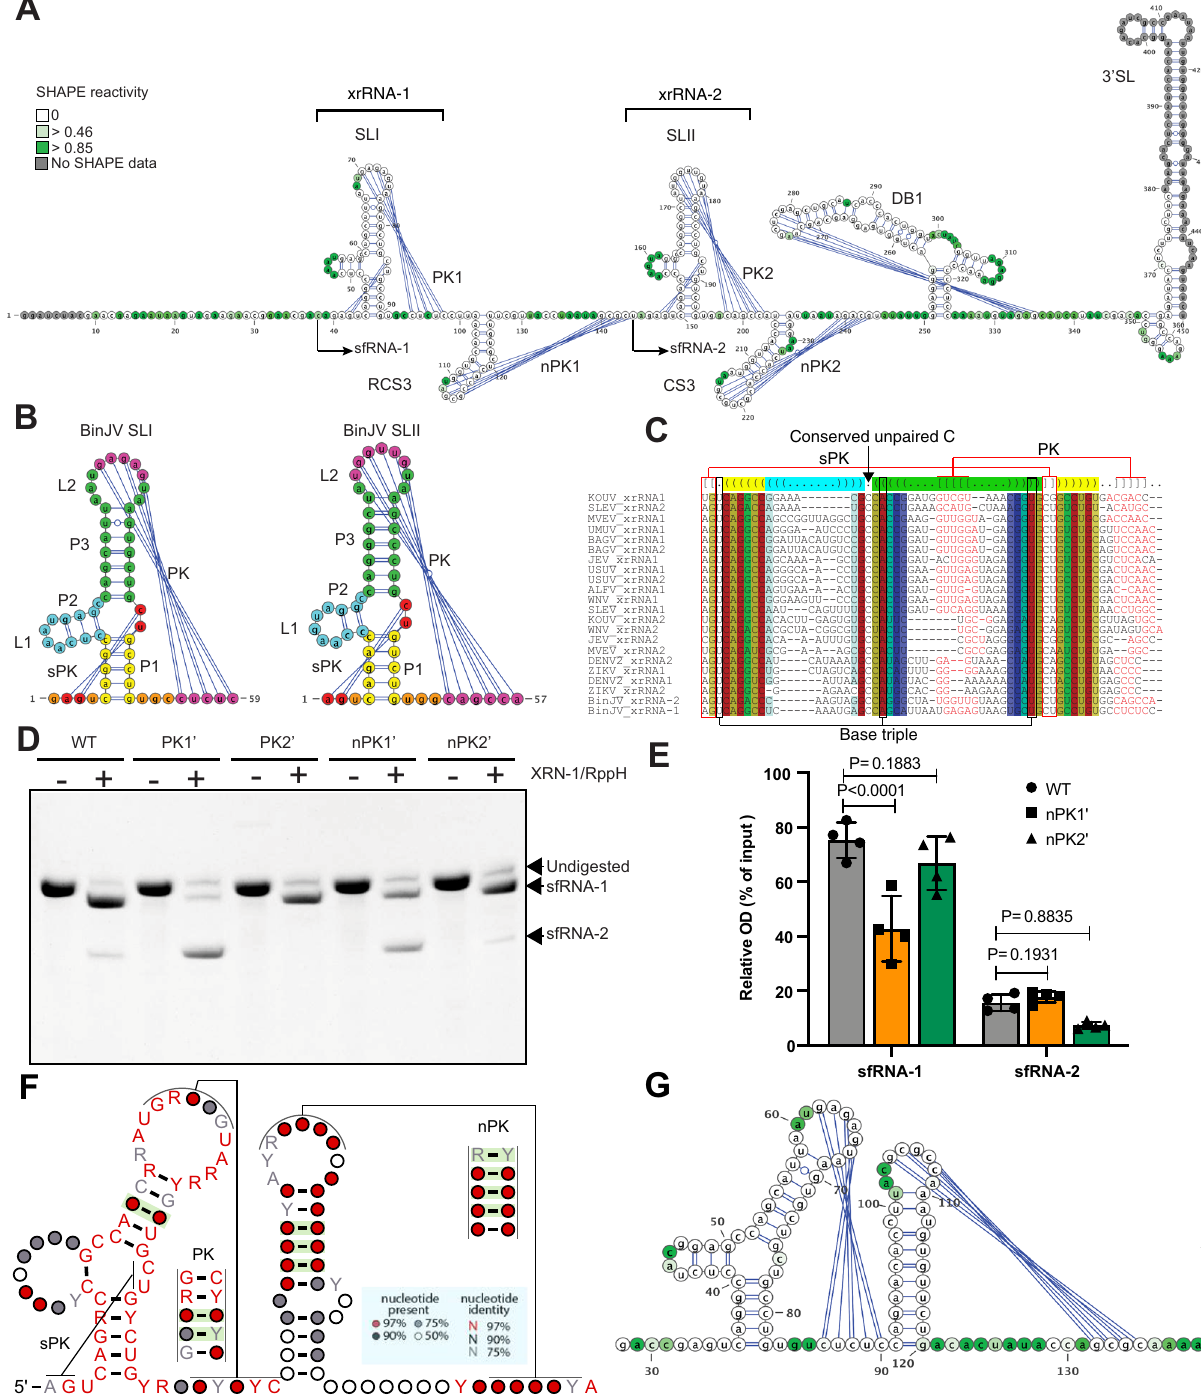
Fig. 2 dISFs contain novel SL-PK elements in addition to canonical class 1a xrRNAs. A Secondary structure of BinJV 3 ’ UTR generated by SHAPE. SL – stem- loop, DB – dumbbell, RCS3 – reverse conserved sequence 3, CS3 – conserved sequence 3, PK – pseudoknot. B Secondary structures of BinJV stem-loops. C Structure-based sequence alignment between BinJV and MBF xrRNAs. D XRN1 resistance assay with WT and mutated BinJV 3 ’ UTRs. Mutations PK1 ’ (GAGAG->CUCUC), PK2 ’ (UGGUUG->ACCAAC), nPK1 ’ (UAGCG->AUCGC) and nPK2 ’ (GCGUC->CGCAG) were introduced into the terminal loop regions of the corresponding stem-loops. The image is representative of four independent experiments that produced similar results. E Densitometry analysis of ( D ). The values are the means of four independent experiments±SD. Statistical analysis is two-sided one-way ANOVA. F Consensus structure of dISF xrRNAs built based on the covariance model. Covarying base pairs are highlighted in green ( G ) Secondary structure of HVV xrRNA generated by